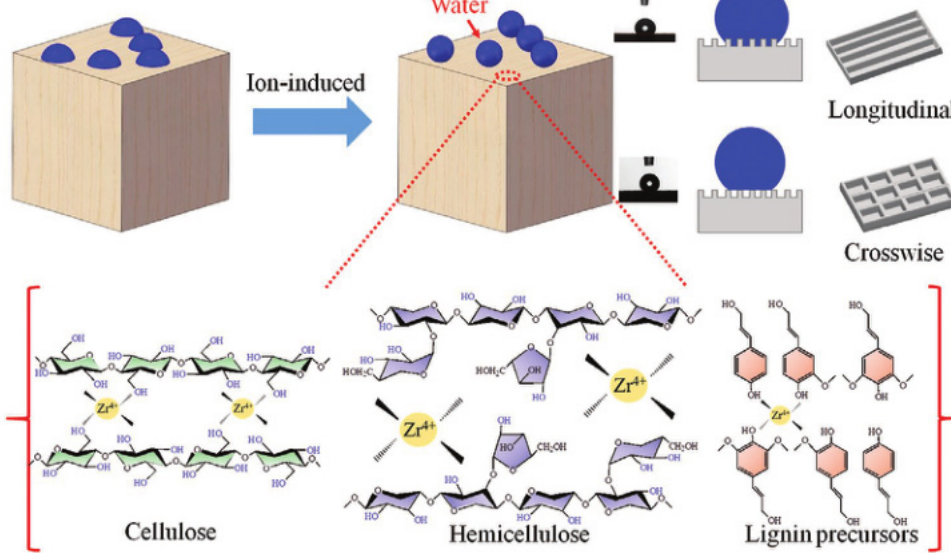
Figure 6. Schematic illustration of metal–ion induced wettability transition over wood surface [82]. Wang et al. [83] only applied a non-toxic chemical solution of silver nitrate (AgNO 3